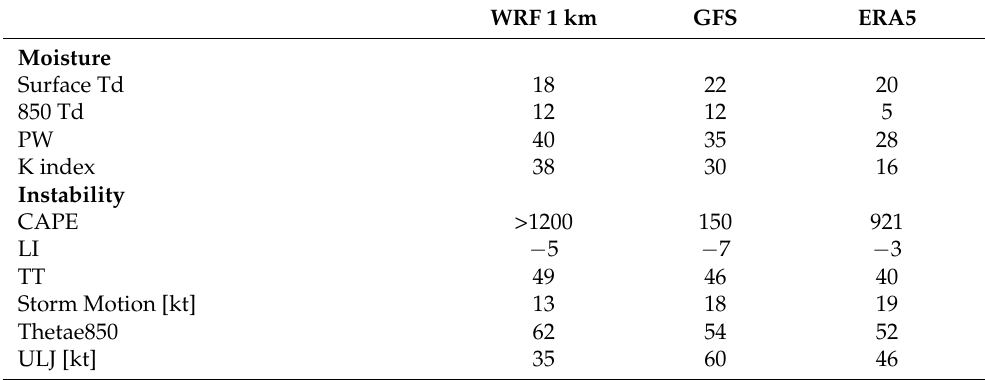
Table 4. Table of comparison between parameters using WRF 1 km and GFS, ERA5